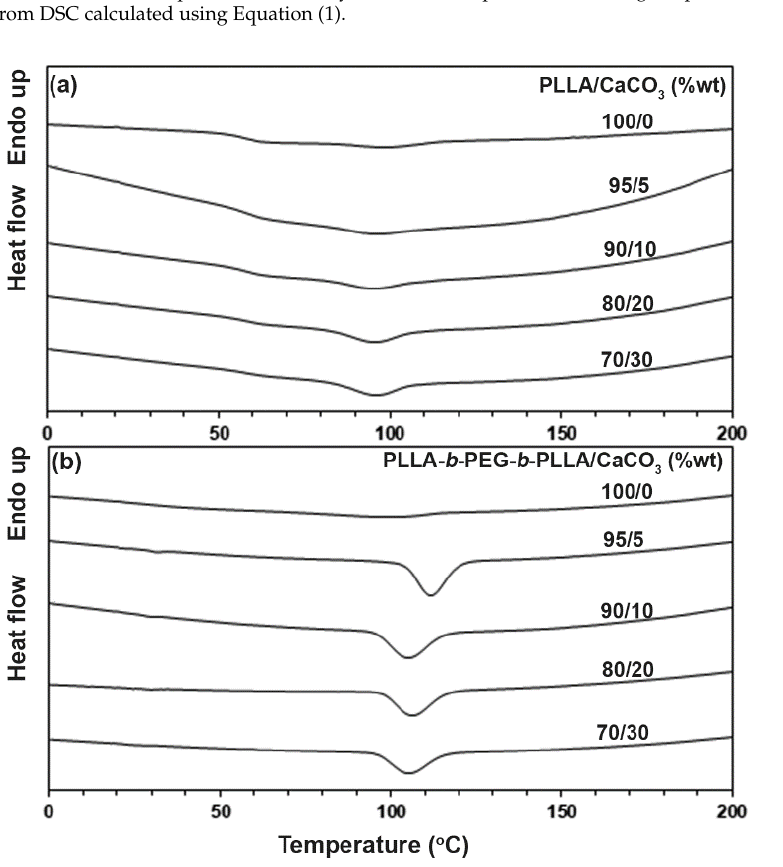
Figure 4. DSC cooling curves of ( a ) PLLA/CaCO 3 and ( b ) PLLA- b -PEG- b -PLLA/CaCO 3 composites with various CaCO 3